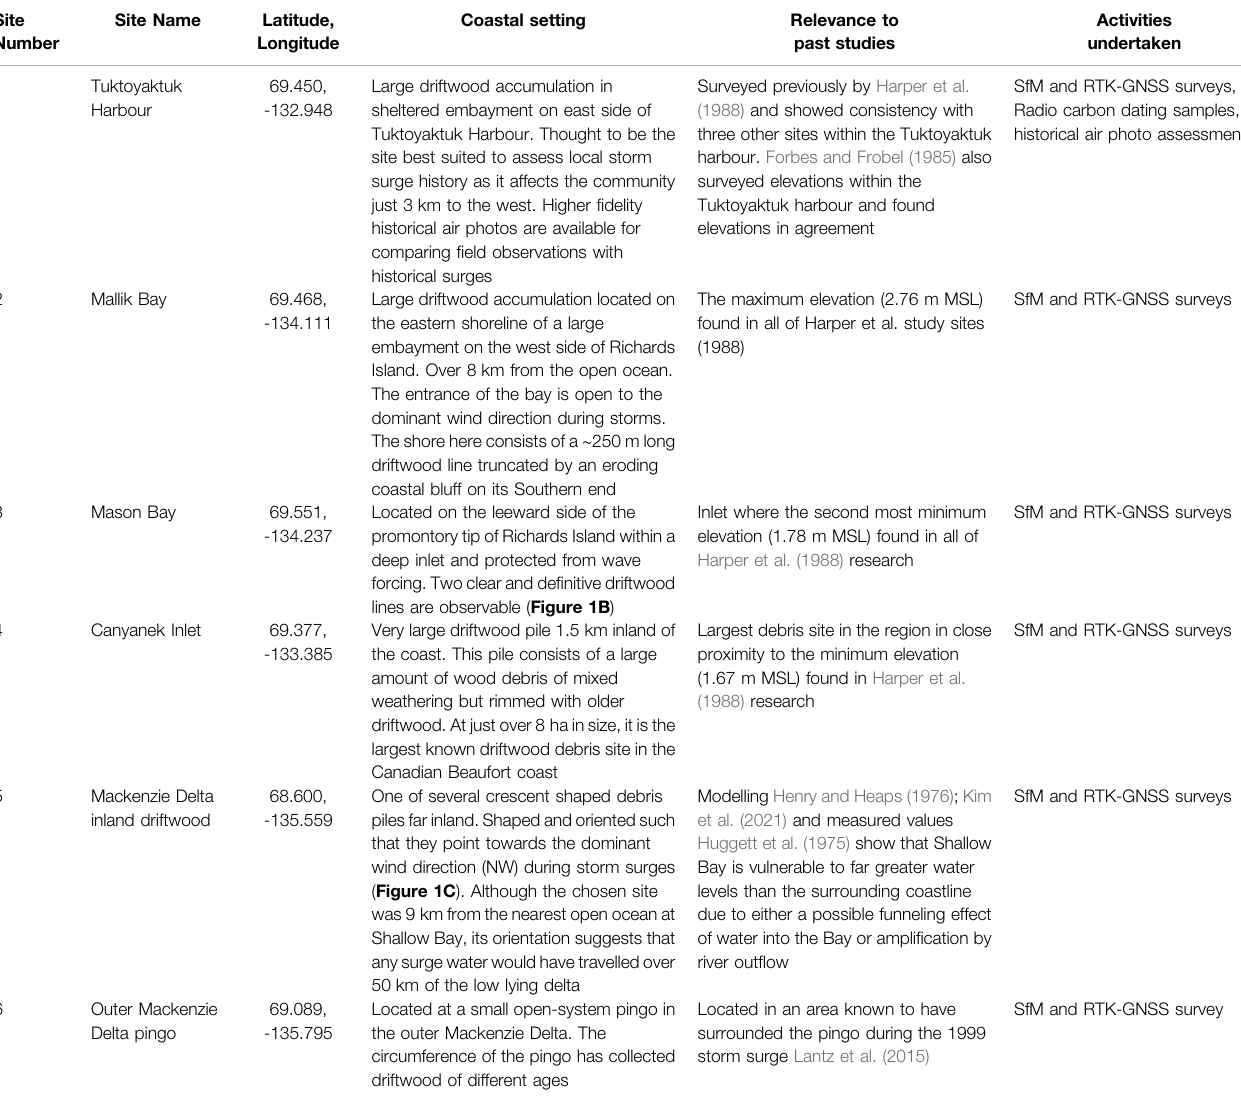
TABLE 2 | Summary of driftwood research sites reported on in this